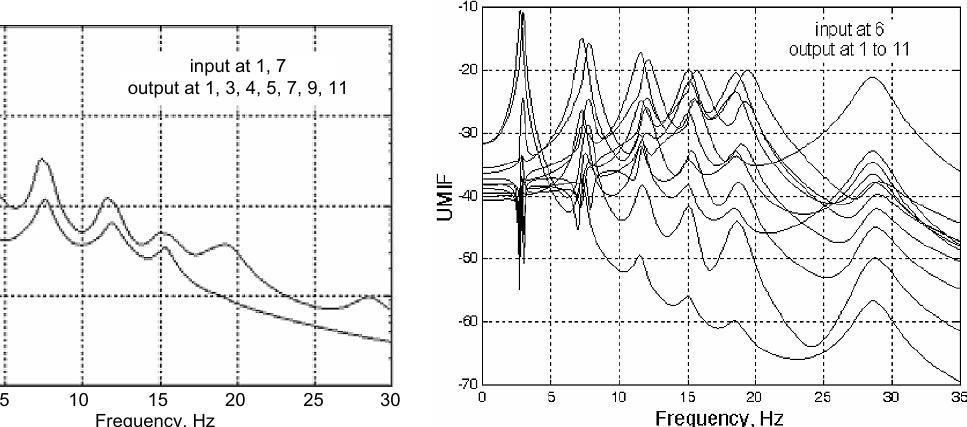
Fig. 14. CMIF for the 11-dof system. Fig. 15. UMIF for the 11-dof system with one input.